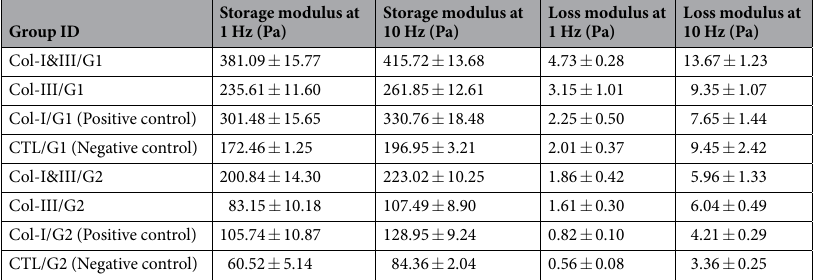
Table 2. Viscoelastic properties of the hydrogels. Storage and loss moduli were measured for the frequencies between 0.01 to 20 Hz. The representative data (mean ± standard deviation) at 1 and 10 Hz is shown (Col-I: collagen type I, Col-III: collagen type III and Col-I&III: the simultaneous presence of Col-I and Col-III; G1 and G2 represent 2% and 1% final glycol-chitosan concentration,